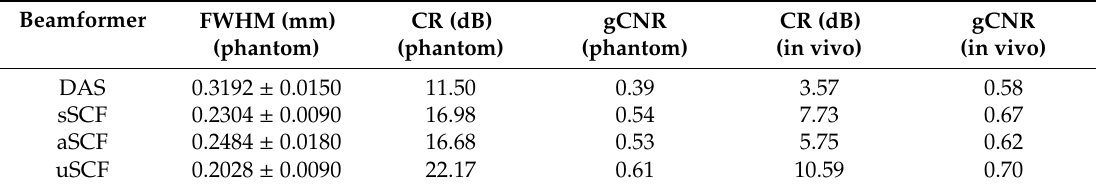
Table 3. Contrast performance from phantom and in vivo.